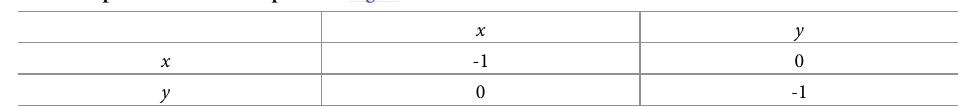
Table 7. Updated matrix A for posets in Fig